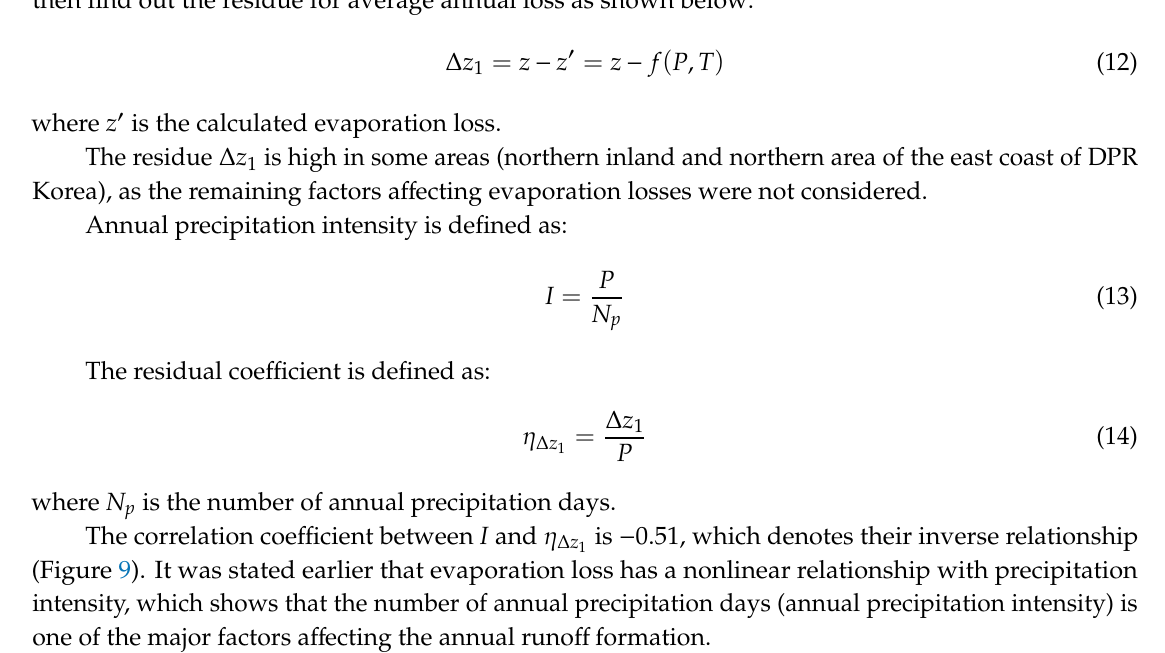
Figure 8. The relationship between the average annual losses z and the average annual temperature T (Taedong River).